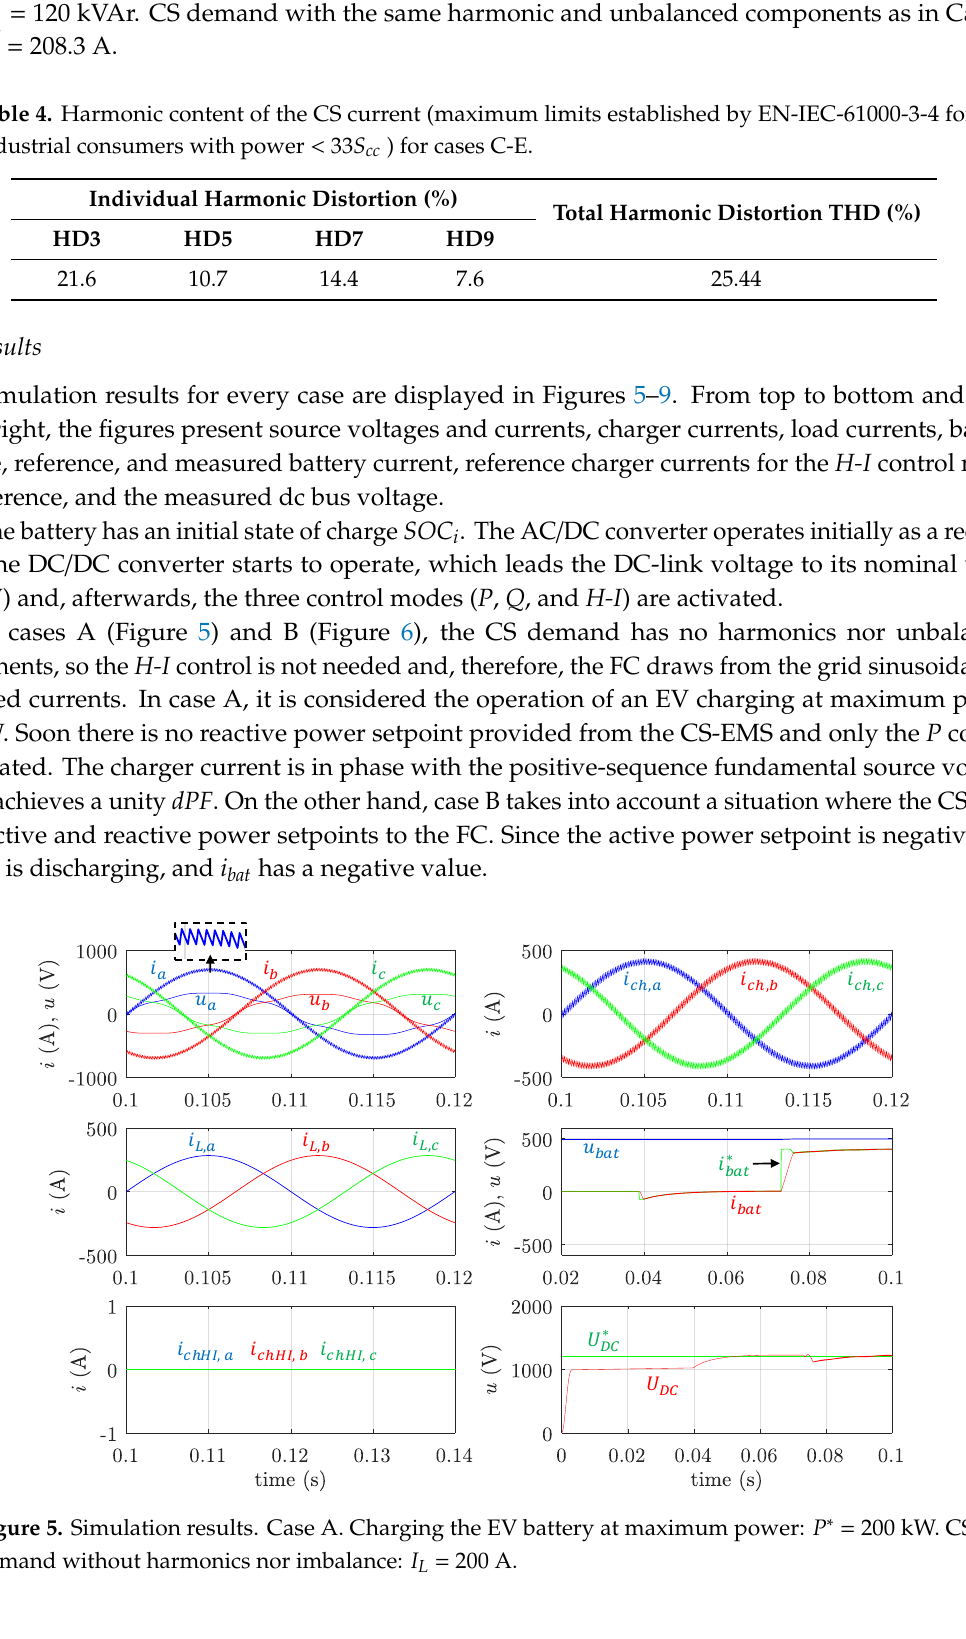
Figure 6 . Simulation results. Case B. Discharging the battery and injecting fundamental reactive power: 𝑃 ∗ = – 160 kW, 𝑄 1∗ = 120 kVAr. CS demand without harmonics. 𝐼 𝐿 = 200 A. In case C (Figure 7 ), the CS demands balanced but distorted currents with the maximum odd harmonic currents up to the 9th order allowed by the EN-IEC-61000-3-4 standard for industrial consumers. The active and reactive power setpoints permit the charger to still have sufficient capacity to take over the total compensation of the harmonics demanded by the CS, so the source current is balanced and sinusoidal. Harmonic content of the load, grid, and charger currents are collected in Table 5. The Total Harmonic Distortion (THD) of the CS current is 25.44% while this value is below 4% in the source current, due to the operation of the charger H control.